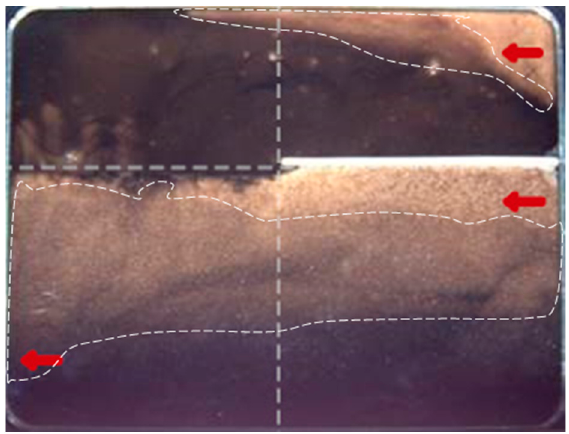
Figure 8. Distribution of miscible zone formed by contact between remaining oil and CO 2 in two layers. (The arrow at the right side is the injection end; the arrow at the left side is the production end).